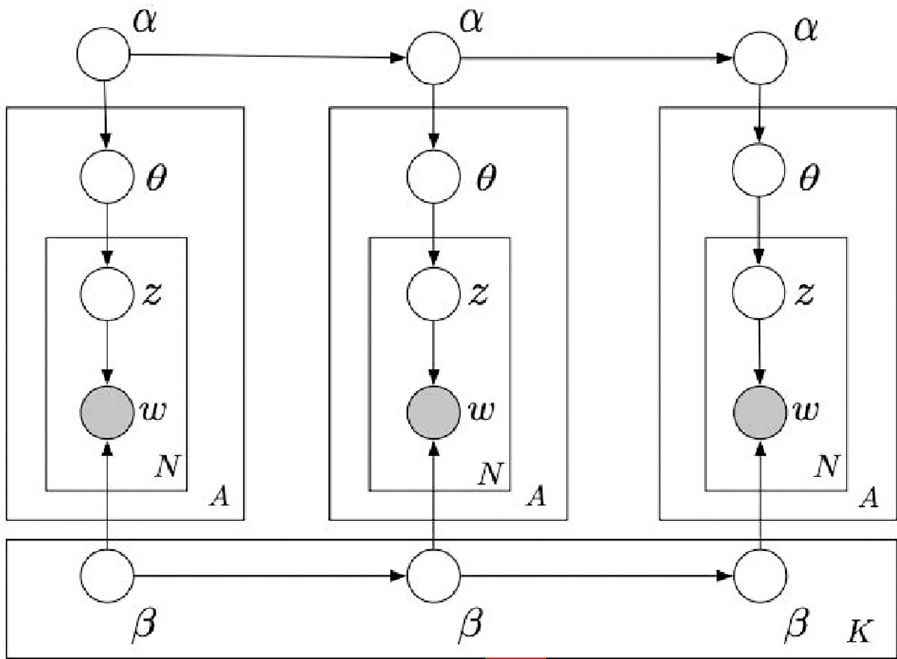
Fig 4. Original DTM